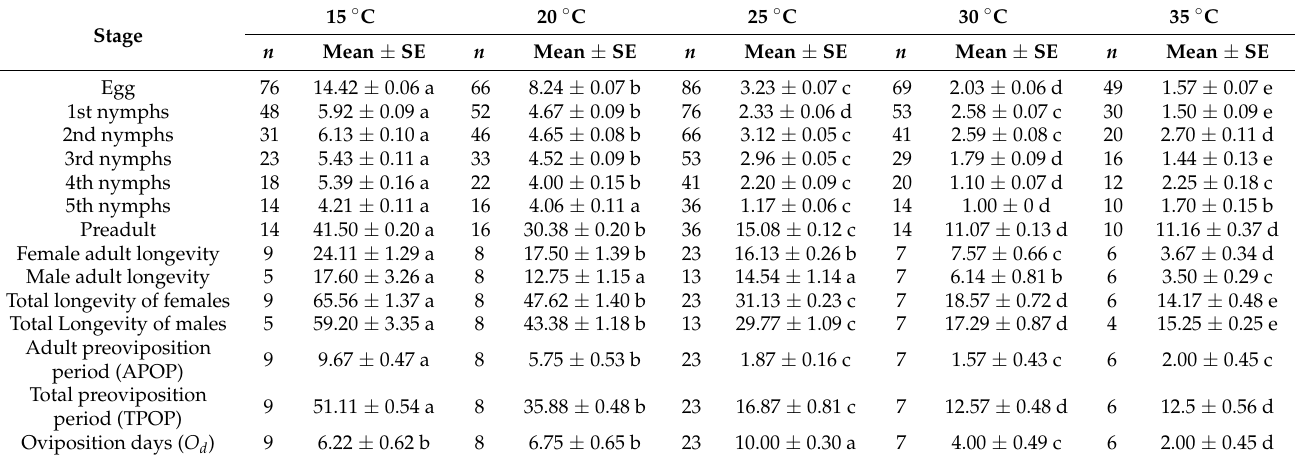
Table 1. Stages and developmental periods (days) (mean ± SE) of the O. minutus feeding on D. minowai at different